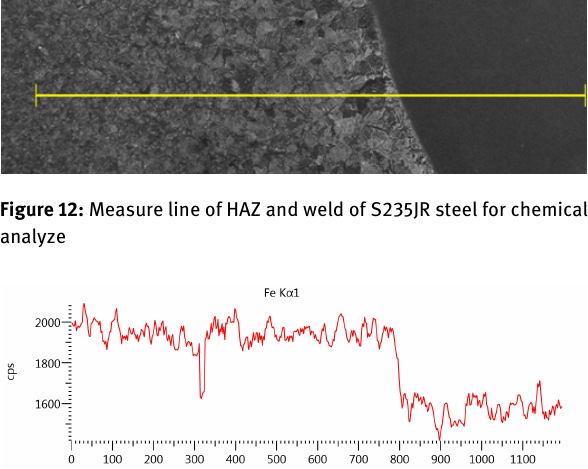
Figure 17: Chromium amount alongside measurement